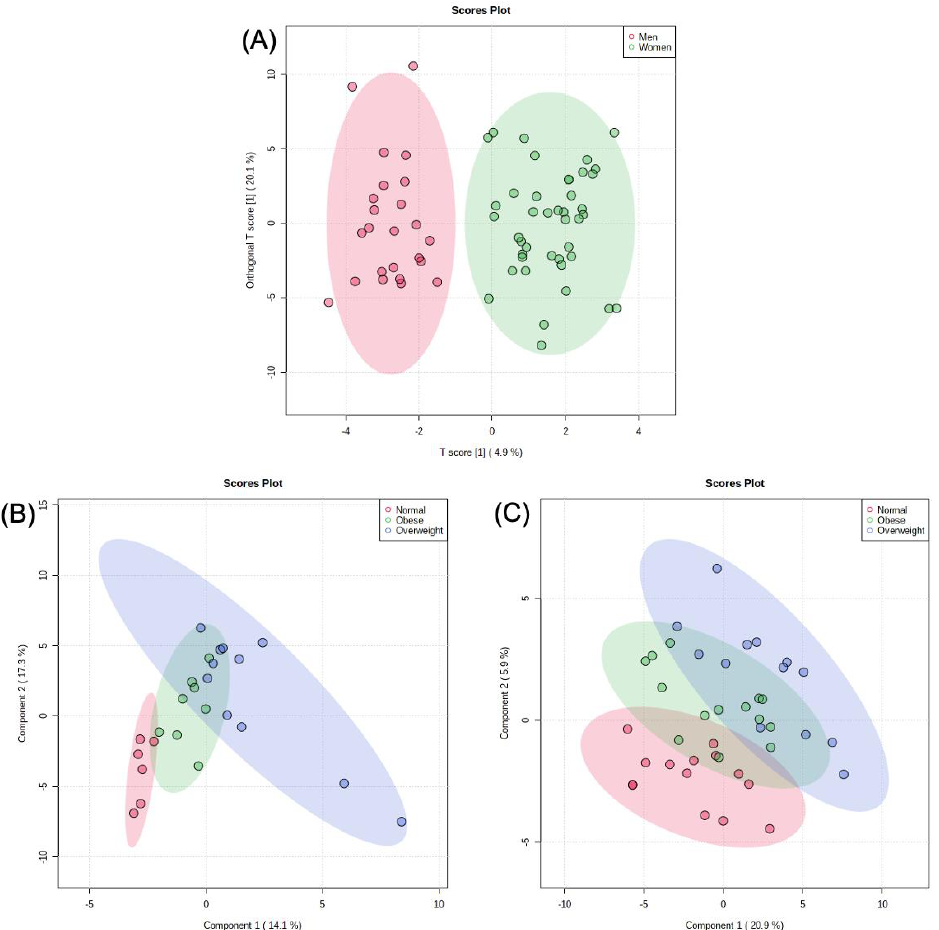
Figure 3. ( A ) Log-transformed OPLS-DA model of men’s metabolites vs. women’s metabolites. ( B ) Log-transformed PLS- DA model comparing men’s BMI using their metabolic profiles. ( C ) Log-transformed PLS- DA model comparing women’s BMI using their metabolic profiles.